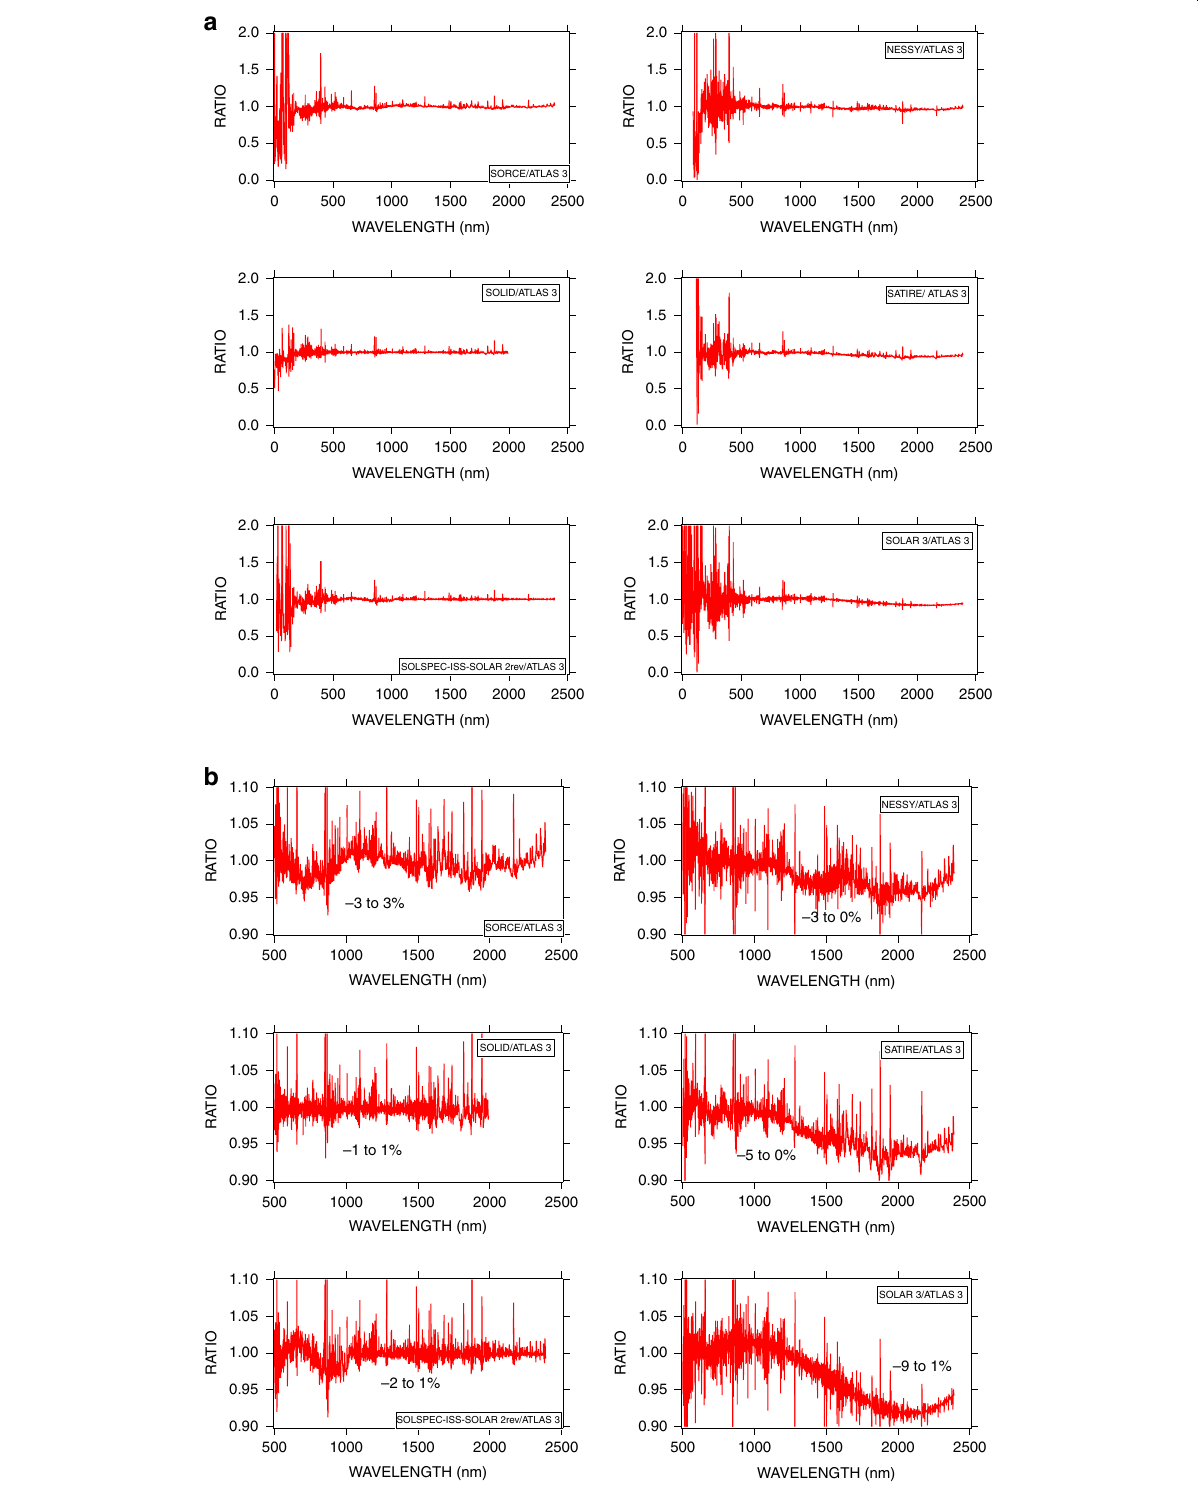
Fig. 7 Ratio of the six spectra to ATLAS3. a From 0 to 2400 nm with a ratio scale from 0 – 2. b Above 500 nm with an expanded ratio scale from 0 to